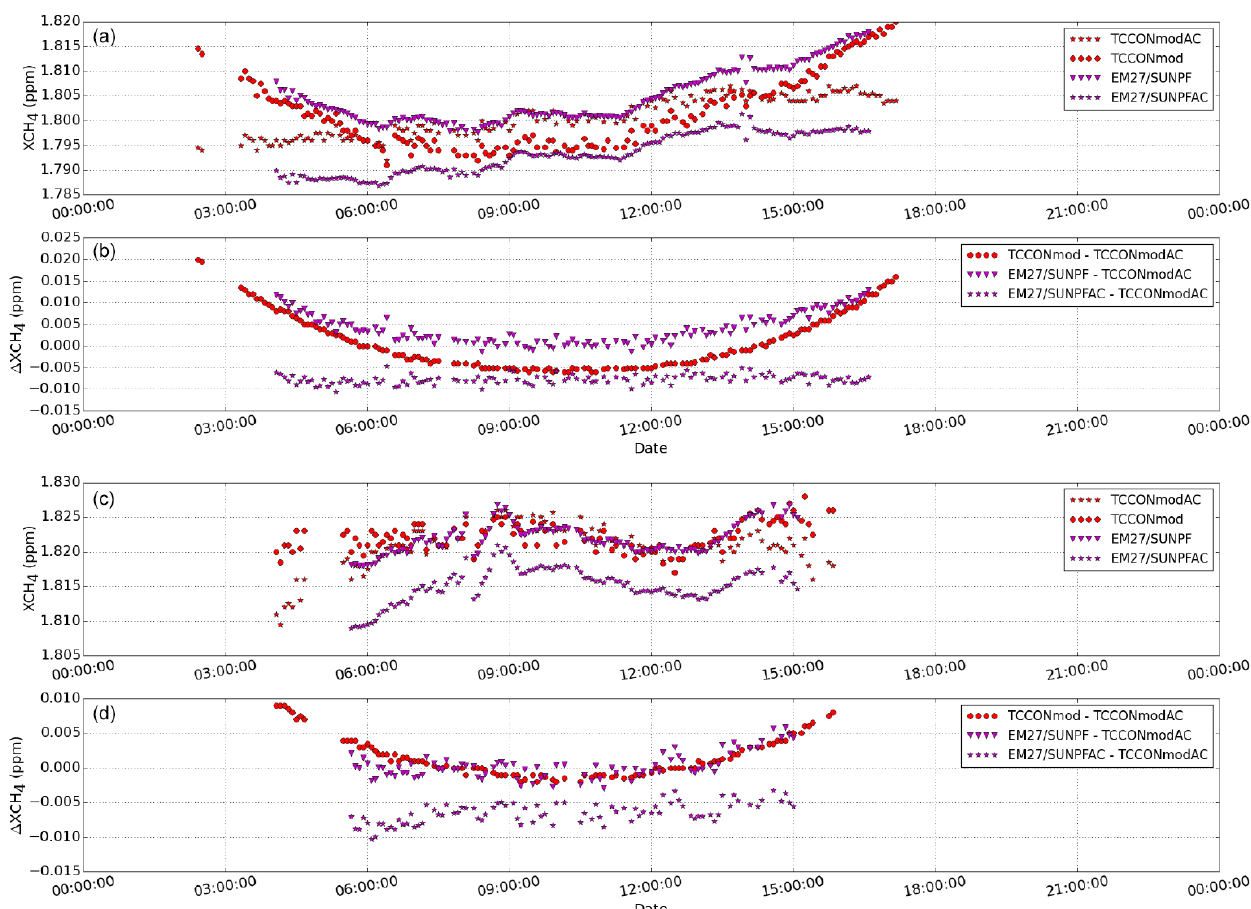
Figure 5. (a) XCH 4 plotted for TCCONmod and EM27/SUN retrievals with the TCCON a priori and with a modified a priori (calculated using in situ, AirCore, and TCCON map files; labelled with AC at the end) for measurements performed on 15 May 2017 at Sodankylä. Panel (b) shows the difference between the two retrievals in absolute units. Panels (c) and (d) show the same plots as mentioned above for measurements performed on 28 August 2017 at